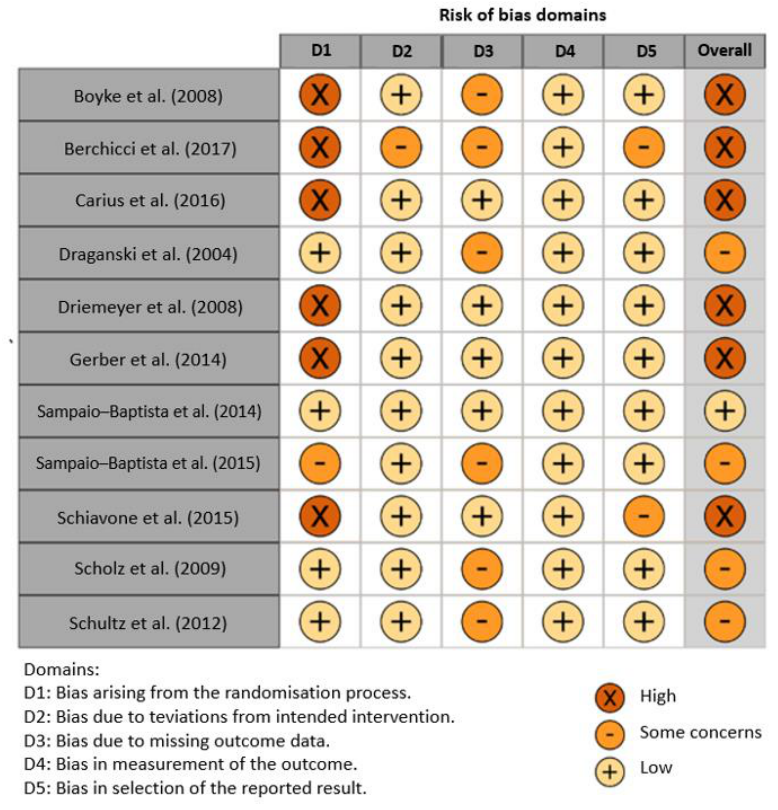
Figure 1. Risk of bias of all included studies [20 – 30].